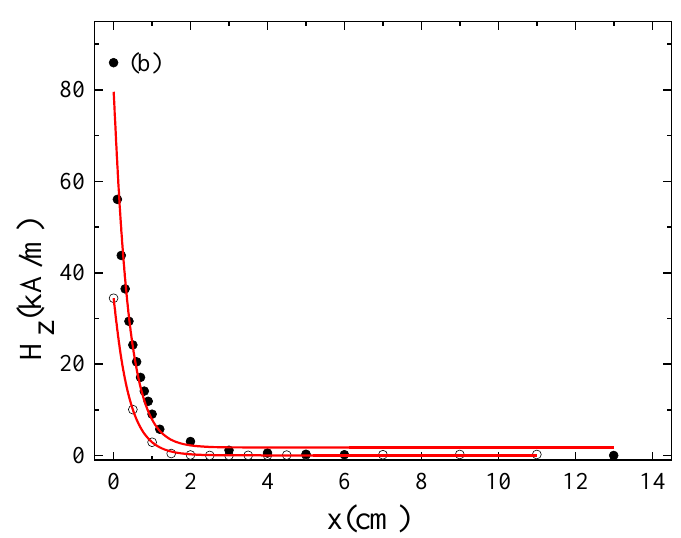
Figure 3. ( a ) GMI voltage, V , and ( b ) magnetic field, H z , as a function of the relative distance, x , between the magnet and the GMI sensor (wire) for ( • ) the ferrite magnet and (o) the energy harvester. Inset in ( a ): schematic of the experimental configuration. The solid line in ( b ) represents the theoretical estimated field according to Equations (A2) and (A3) (Appendix A).